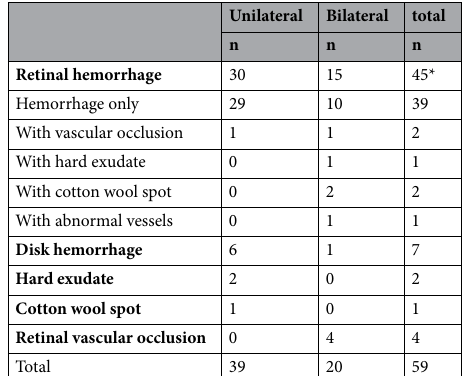
Table 3. Self-reported diabetes mellitus (p < 0.001) and older age (men; p = 0.002, women; p = 0.02) were associ- ated with the vascular events in both genders, and self-reported hypertension was associated with the events in the women (p < 0.001) but not in the men (p = 0.83). Smoking (p = 0.02), higher systolic blood pressure (p = 0.01), lower frequency of consumption of meat (p = 0.006) and coffee (p = 0.01) were associated with the vascular events